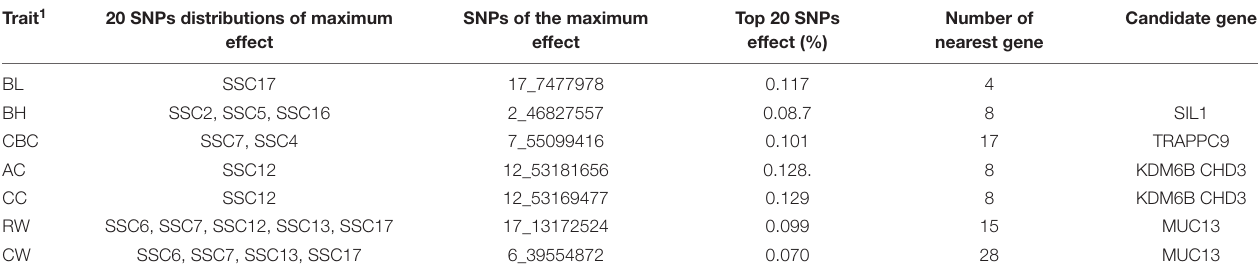
TABLE 4 | Overview of ssGWAS location for the percentage that explains the proportion of genetic variance. Trait 1 20 SNPs distributions of maximum